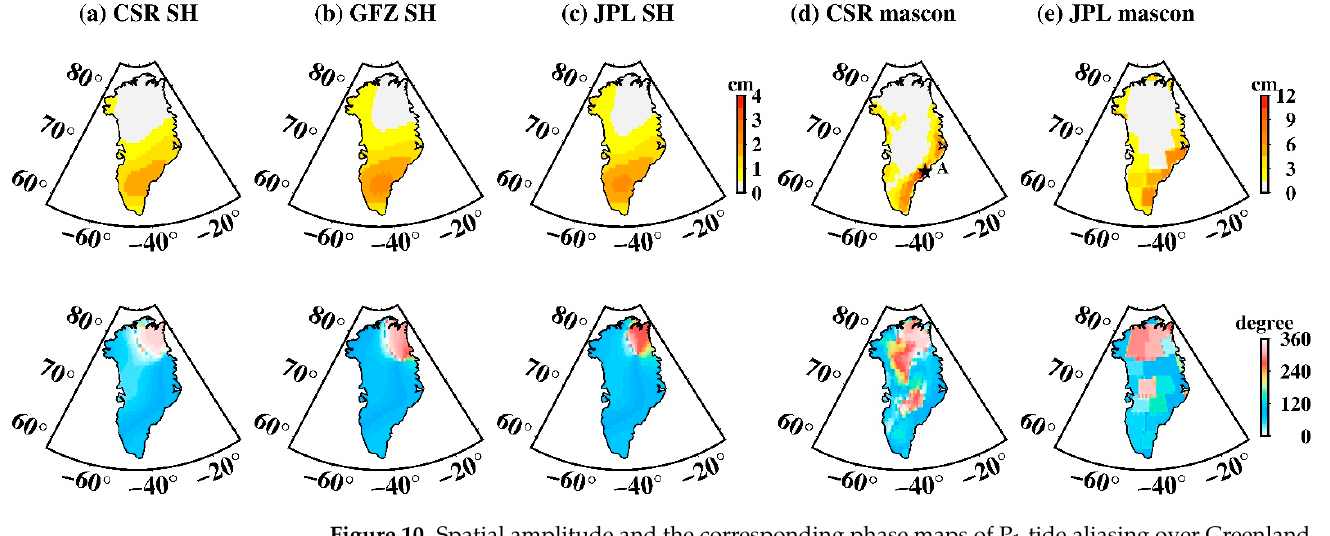
Figure 10. Spatial amplitude and the corresponding phase maps of P 1 tide aliasing over Greenland. ( a – e ) Estimated from CSR SH data, GFZ SH data, JPL SH data, CSR mascon data, and JPL mascon data, respectively. The upper row is the spatial amplitude and the bottom row is their corresponding phase.